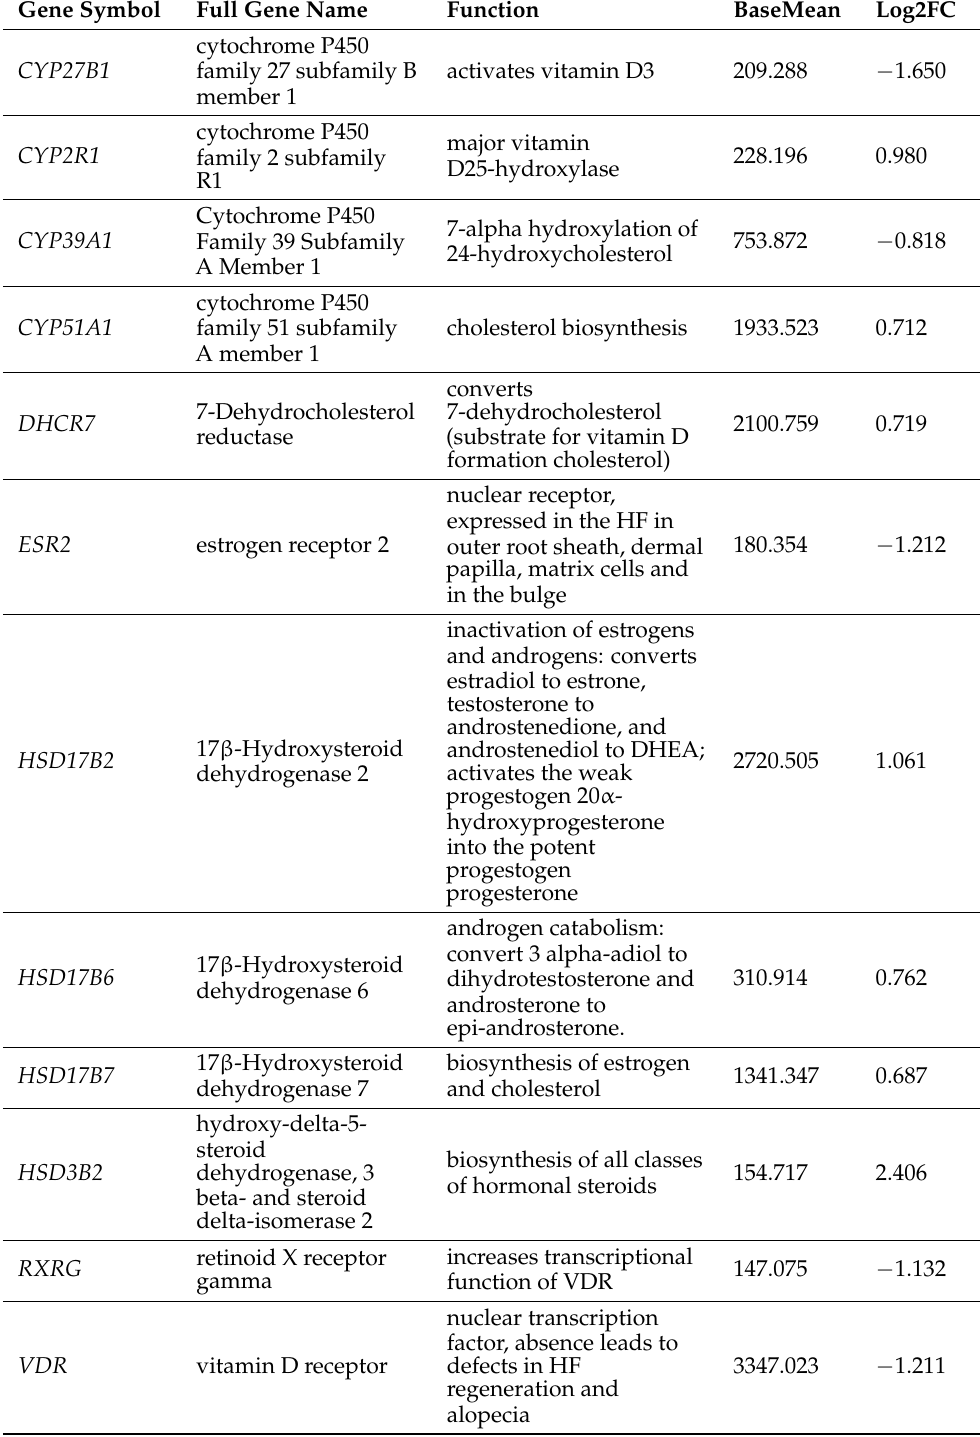
Table 8. Differentially expressed genes associated with either vitamin D or steroid hormone metabolism comparing unaffected skin of control dogs and dogs affected with aRFA (n = 11) and alopecic skin of dogs with aRFA (n =